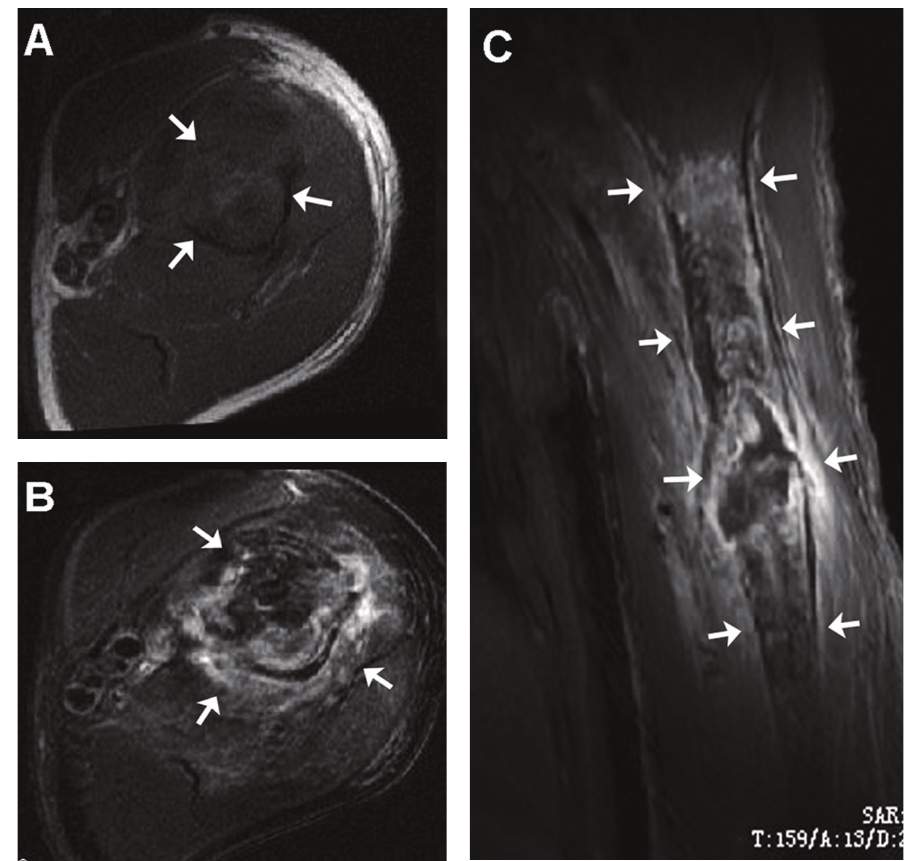
Figure 2: MRI of left shoulder demonstrated isointensity and mild-hypo-intensity signal on T1-weighted images (A), hyperintensity signal on T2-weighted images (B), and inhomogenily enhanced after Gd-DTPA administration (C) in humeral midshaft and surrounding soft tissues. These abnormal signals prompted bone malignancy and pathologic